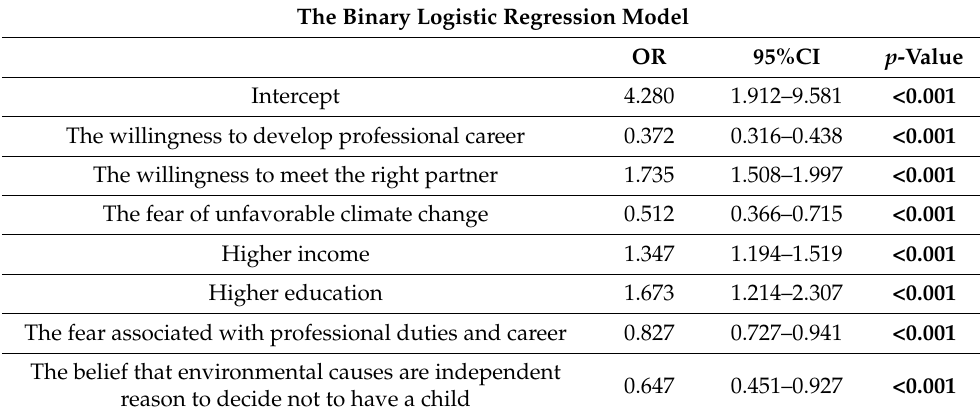
Table 6. The logistic regression model evaluated the impact of tested parameters on the willingness to have a child and was adjusted to the baseline characteristics of the enrolled